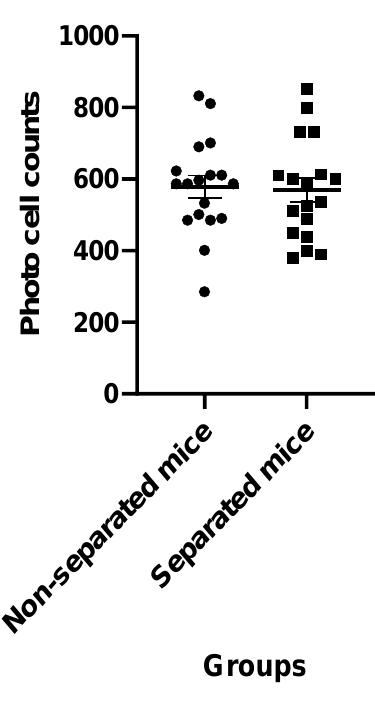
Figure 7. Average of locomotor activity of maternally separated mice as measured by the number of light beam interruptions compared to the non-separated mice ( n = 18/each group). There was no significant difference between the groups ( p >